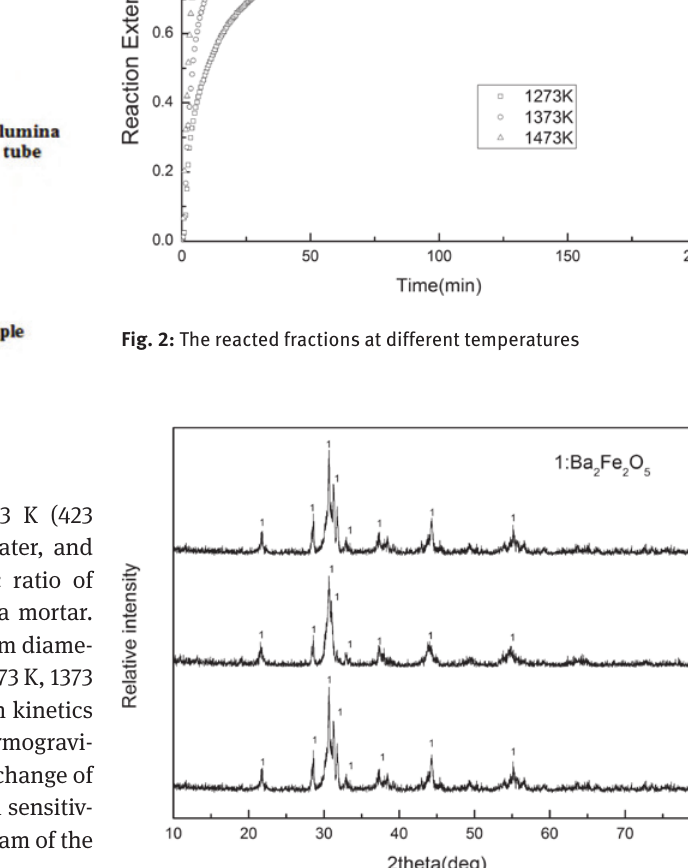
Fig. 3: The XRD patterns of reaction products at 1273 K, 1373 K and 1473